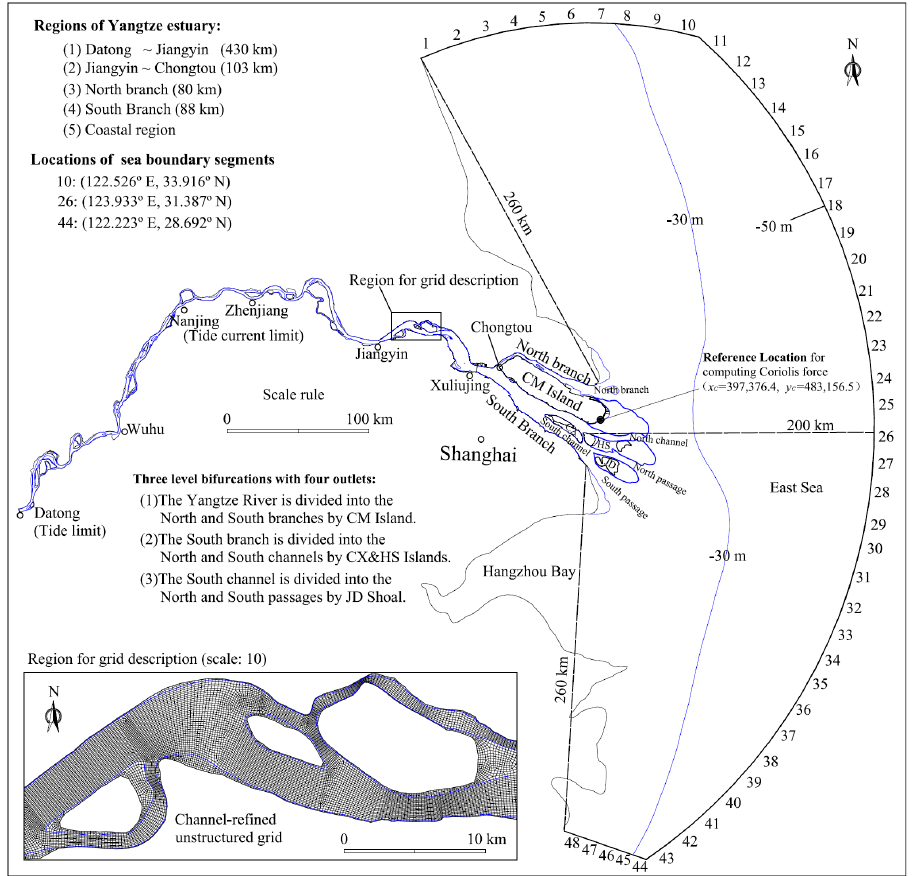
Figure 2. Description of the bound, the three-level bifurcations and the strong river-coast-sea coupling in Yangtze Estuary (computational domain and grid are also